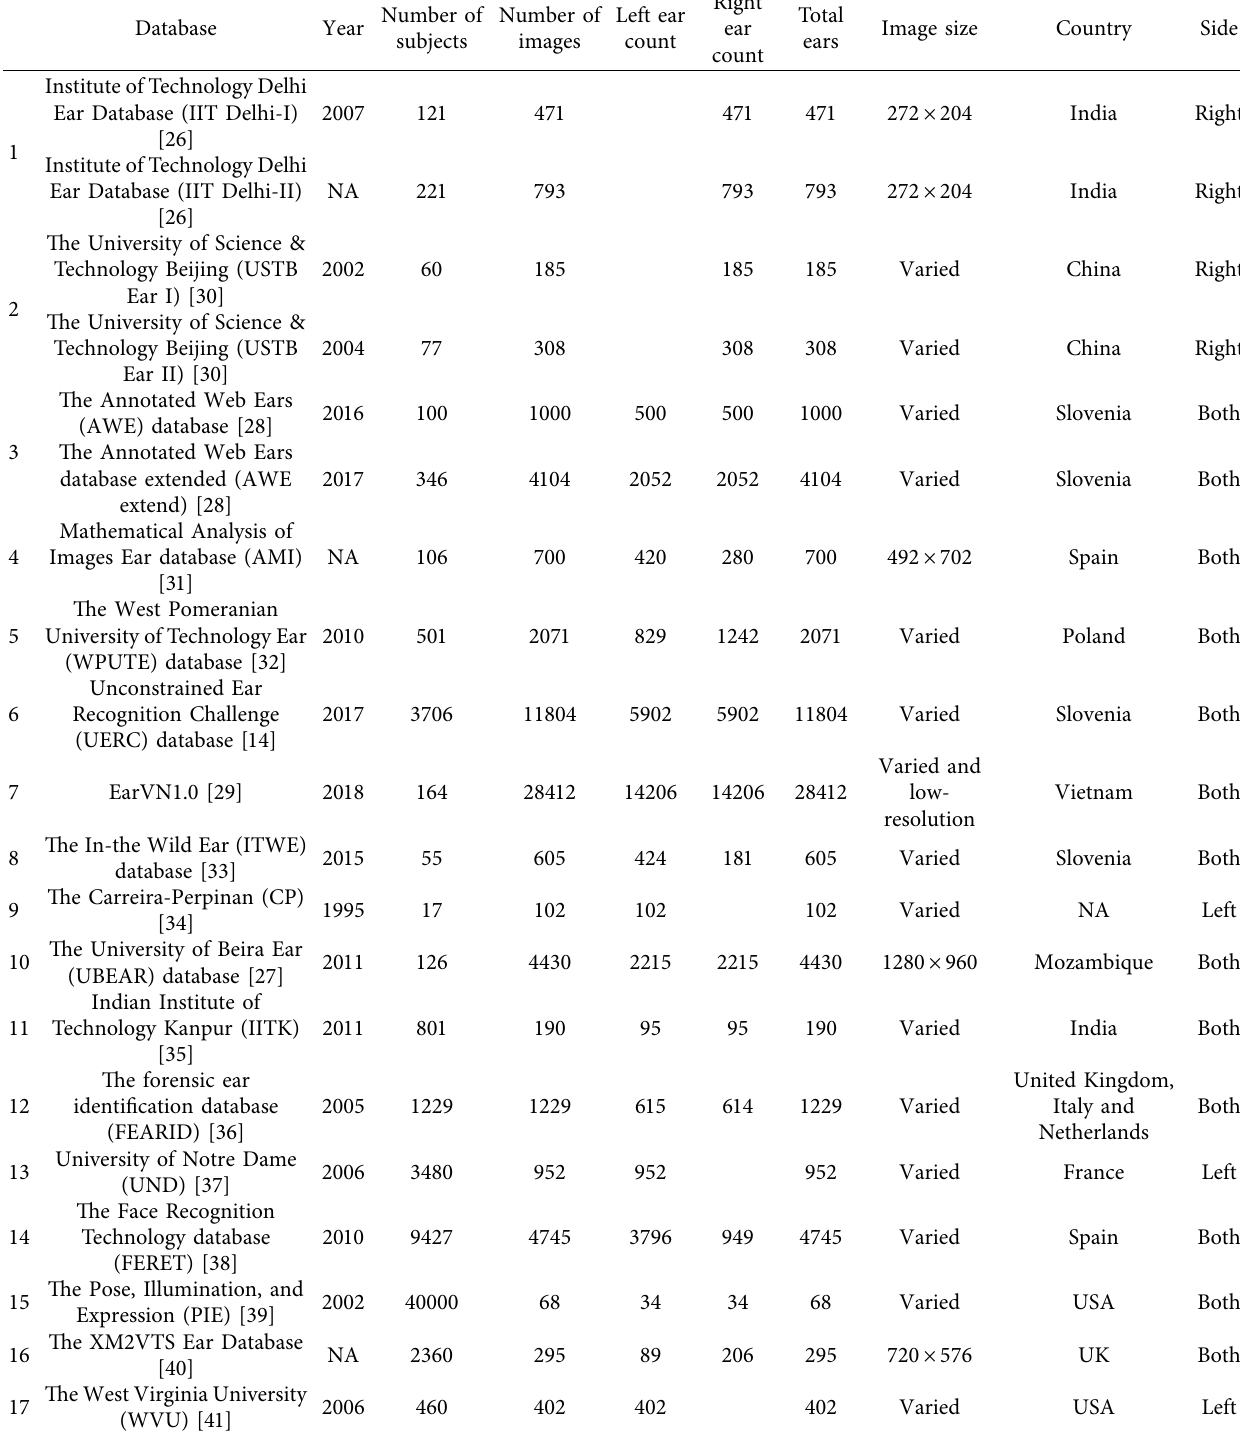
Table 3: Summary of